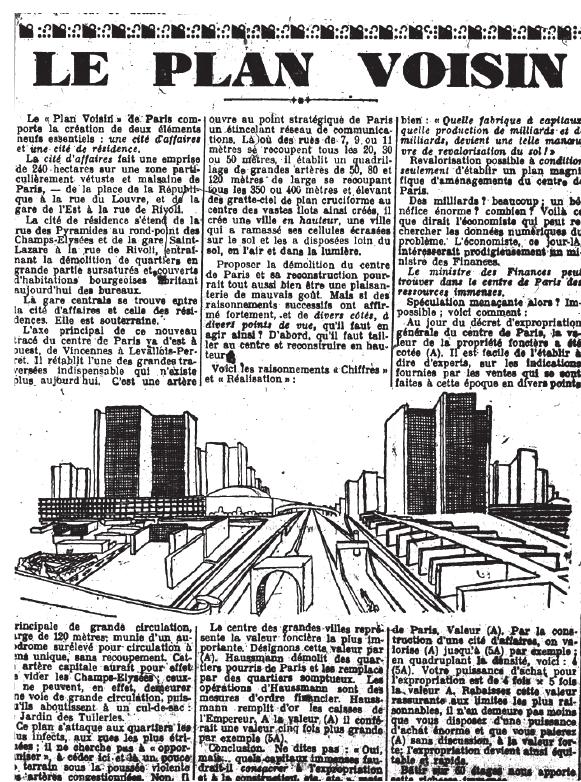
fig. 1. newspaper image, George Valois, “le Plan